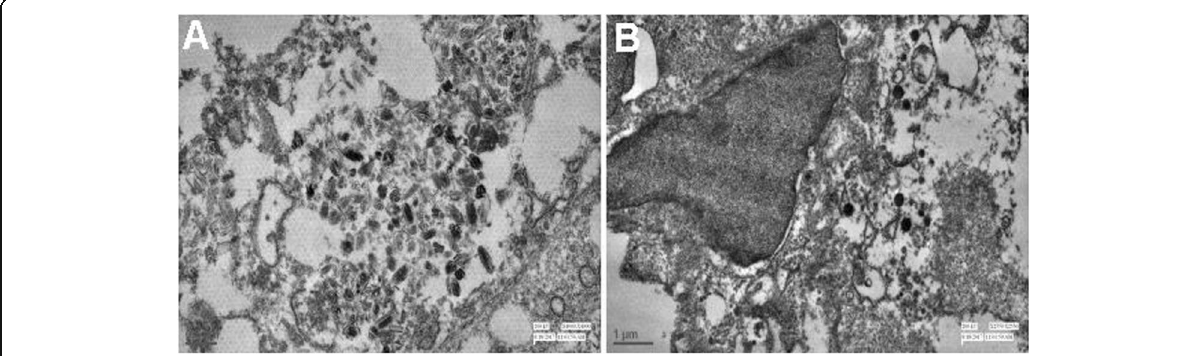
Fig. 4 Electron microscopic features: Ultrastructural examination revealed the presence of melanosomes ( a ) and neurosecretory granules ( b ) in the cytoplasm of tumor